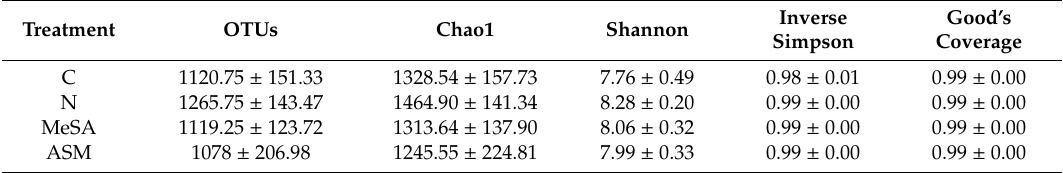
Table 1. Alpha diversity indices in rhizosphere microbiome of pine seedlings.